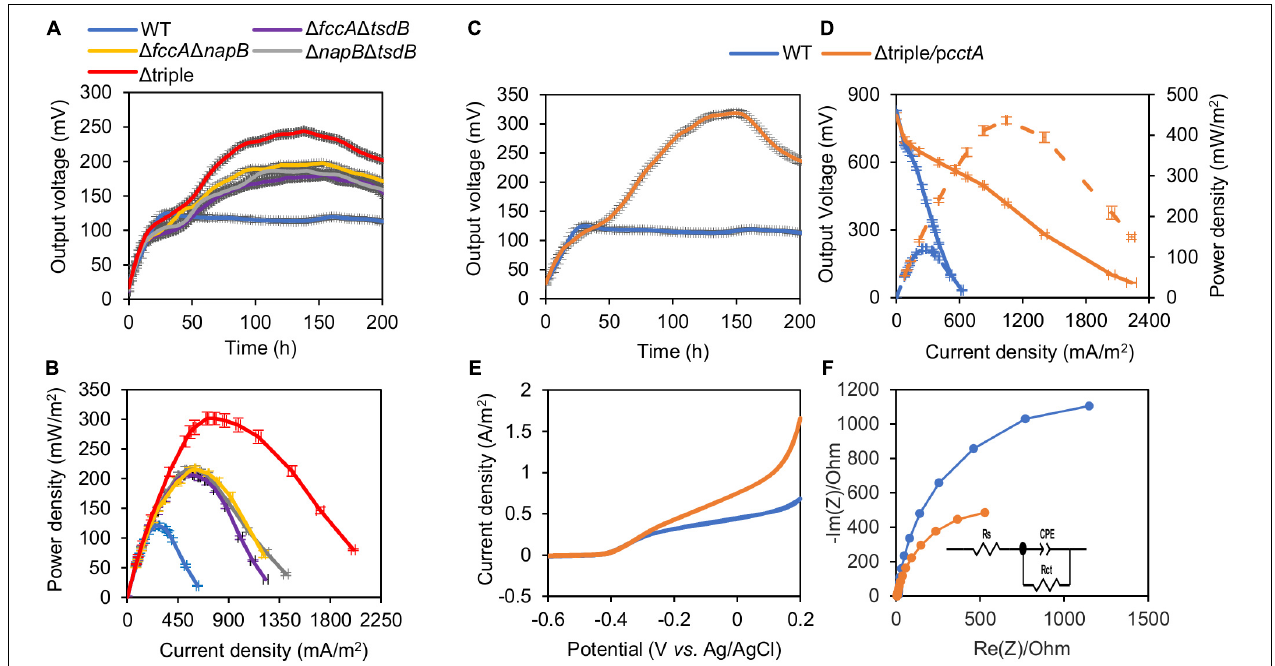
FIGURE 5 | Optimized MFC performance of engineering strains. Data from mutants are given in panels (A–F) show triple mutants overexpressing cctA with 0.5 mM IPTG. (A,C) Output voltage of MFCs incubated with the indicated strains across the 2,000 (cid:127) external resistor. (B) Power density curves determined by measuring the stable output voltage generated across various external resistances. (D) Polarization curves and power density curves (dashed lines) determined by measuring the stable output voltage generated across various external resistances. (E) Cyclic voltammetry (CV) characterization of the MFC with inoculations of the control strain and indicated recombinant strains under turnover condition, respectively. (F) Nyquist plots (0.01 Hz to 100 kHz at the bias potential 0.2 V vs. Ag/AgCl with a 5-mV perturbation signal of different strains in MFCs. Three independent operations were performed, and data are presented by the means ± SD. In all panels, the differences in the peak values between WT and each of mutants under test were <